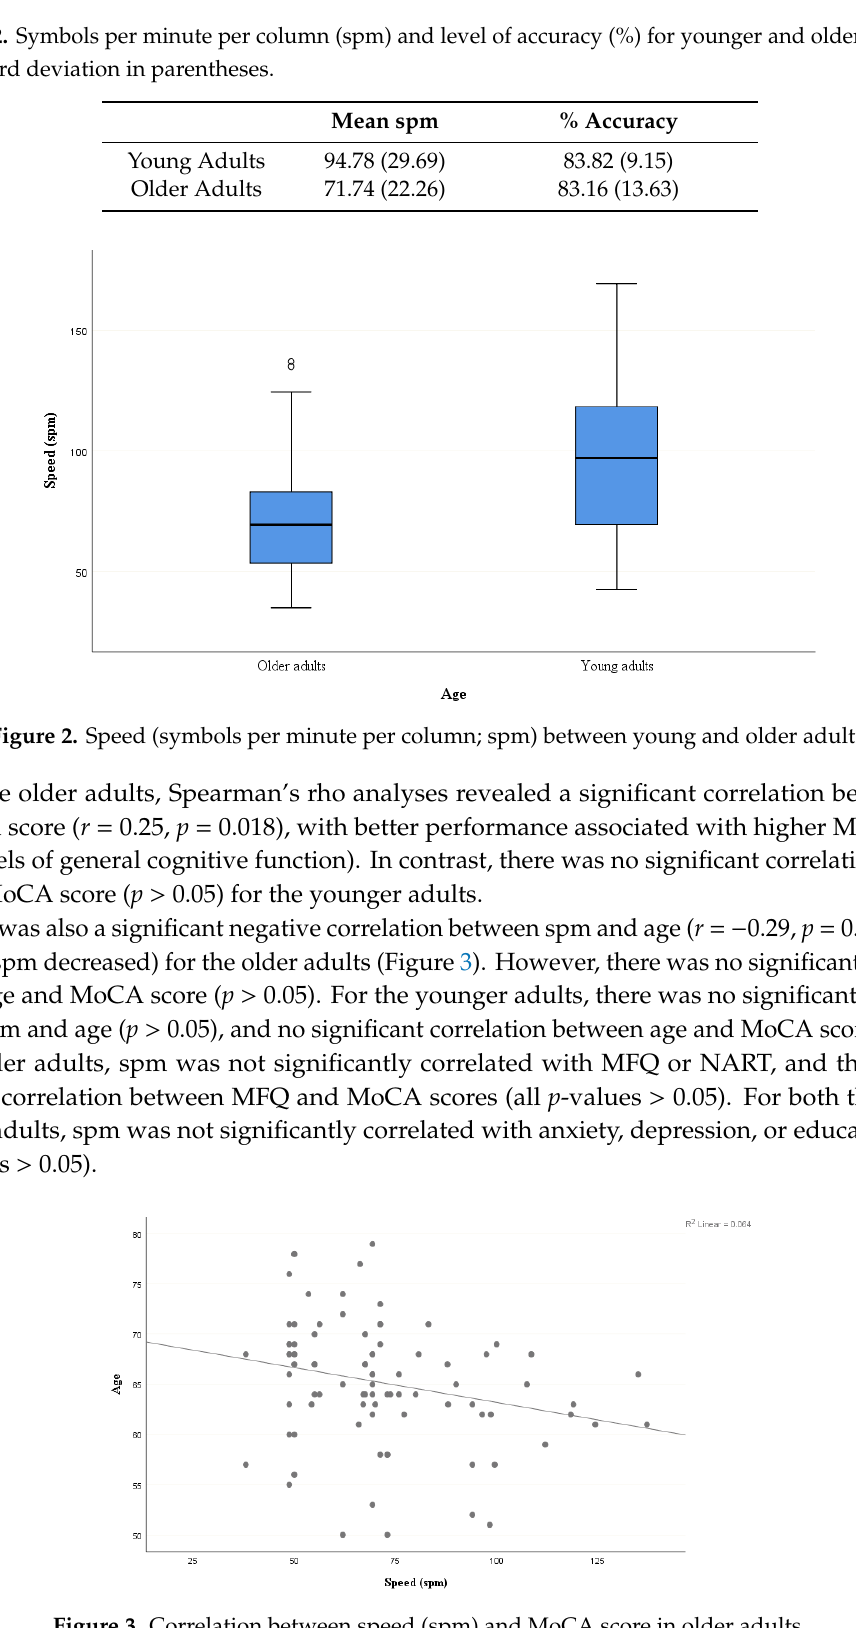
Table 2. Symbols per minute per column (spm) and level of accuracy (%) for younger and older adults. Standard deviation in parentheses.